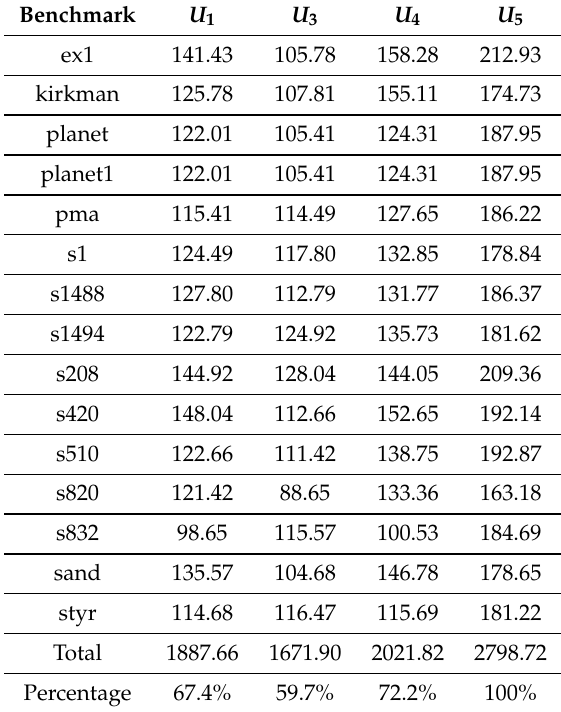
Table 9. Results of experiments (the operating frequency,